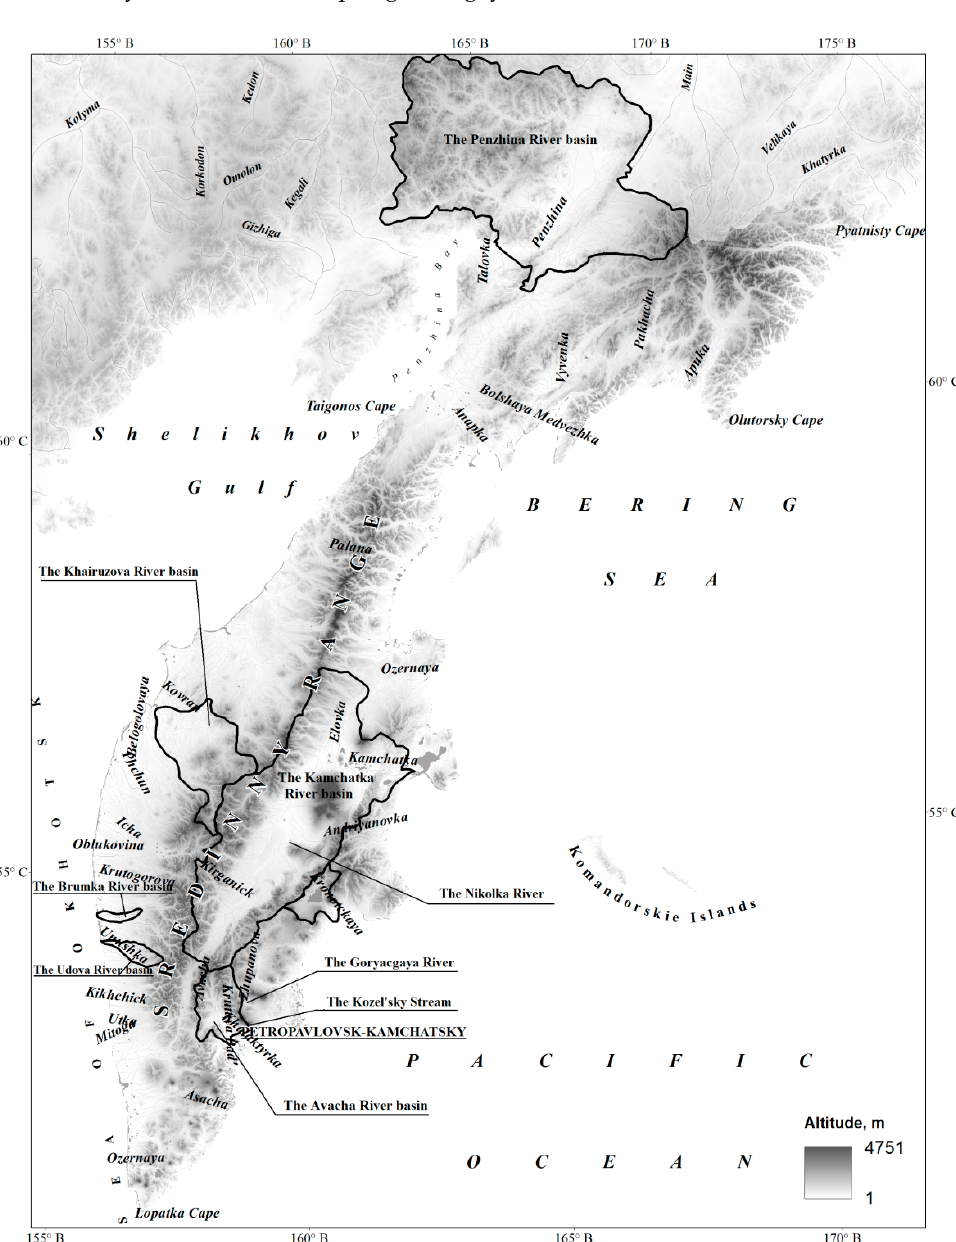
Figure 1. Study region of the Kamchatsky Krai and rivers mentioned in the paper.